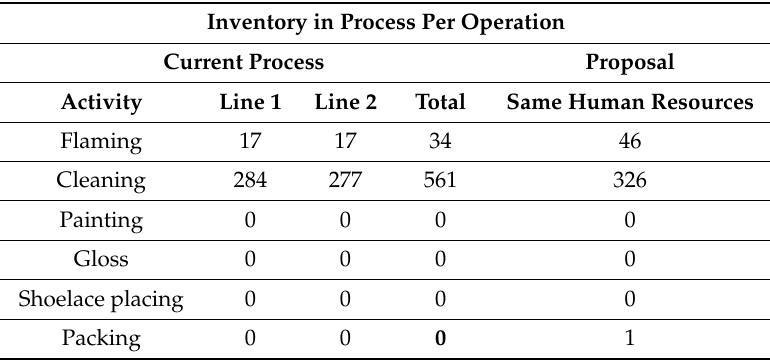
Table 6. Inventory in the process by operation: